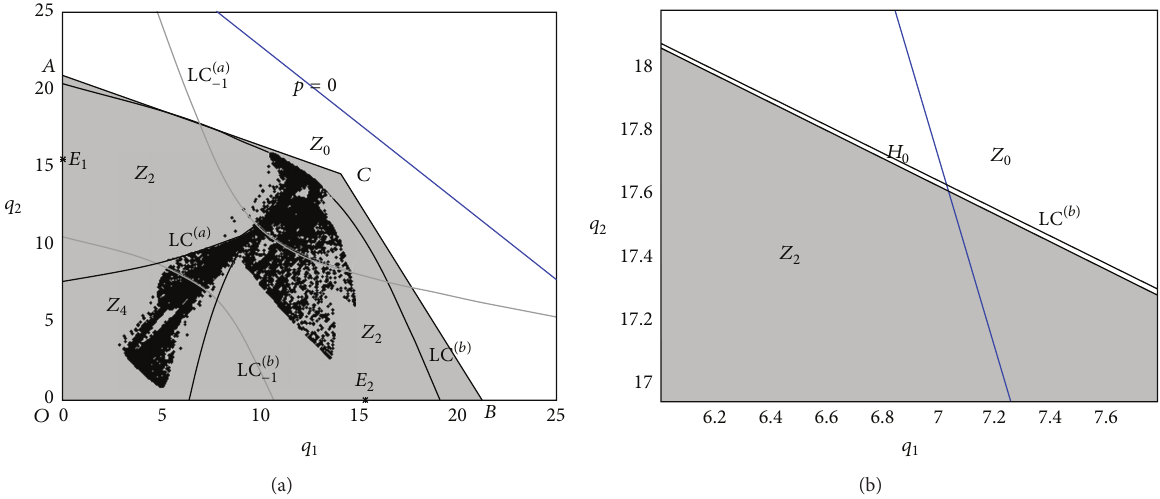
Figure 4: (a) Portions of the basin of attraction of trajectories that converge to invariant axes for map 𝑀 1 enter 𝑍 2 region. This causes the appearance of several holes in the basin of attraction of the interior attractor. The blue line 𝑝 = 0 represents points in which the market price equals zero. (b) Enlargement view of the birth of the portion of the basin of the attraction of the attractors on the axes in region 𝑍 2 . Parameter set: 𝑎 = 7.2 , 𝑏 = 0.22 , 𝑐 = 0.4 , 𝛾 = 0.9 , and 𝛼 = 0.427